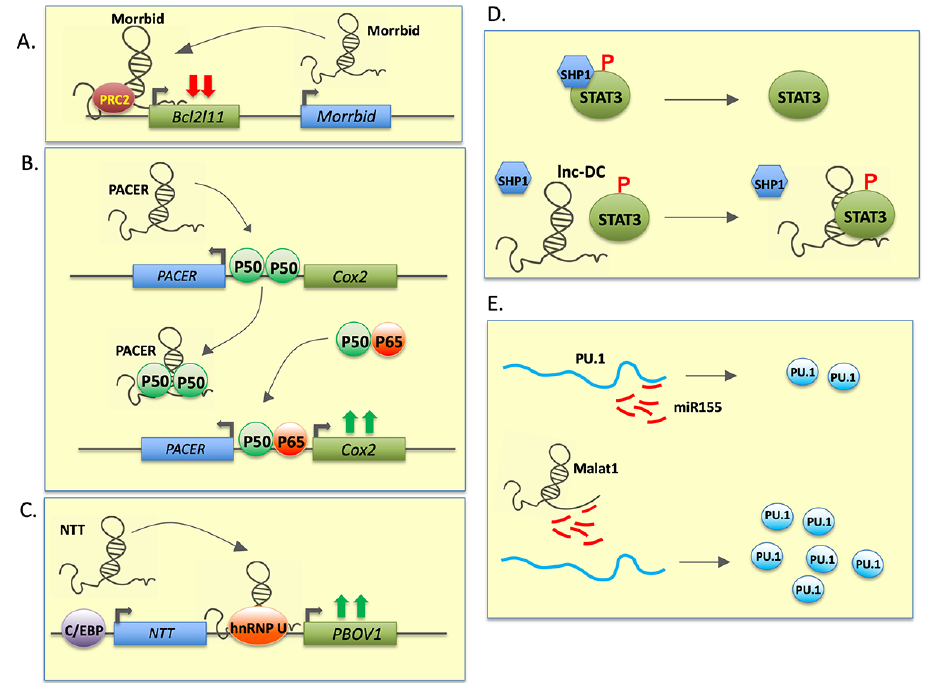
Figure 2. Schematic diagram depicting different long noncoding RNA mechanisms in myeloid cells. LncRNAs are modular molecule and can act as decoys, signals, guides, or scaffolds. In this